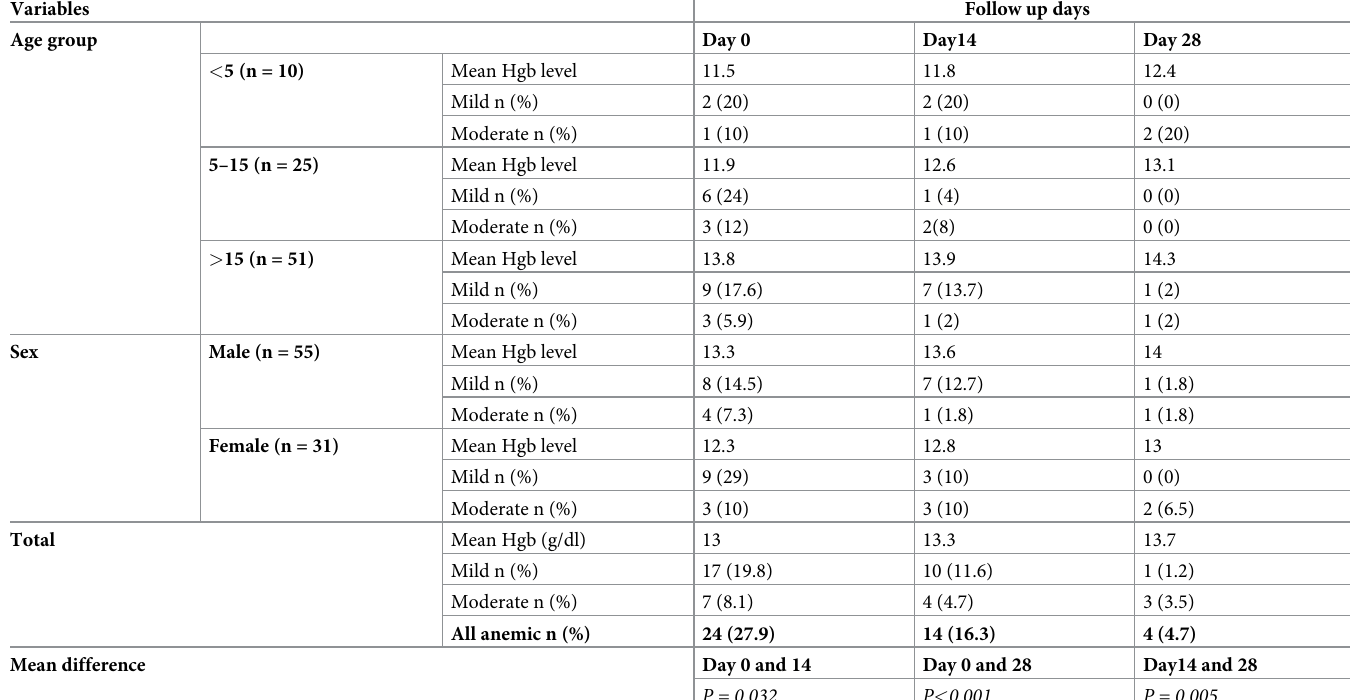
Table 4. Anemia status among study participants following chloroquine treatment in Shewa Robit Health Center, northeast Ethiopia from November 2020 to March 2021. Variables Follow up days Age group